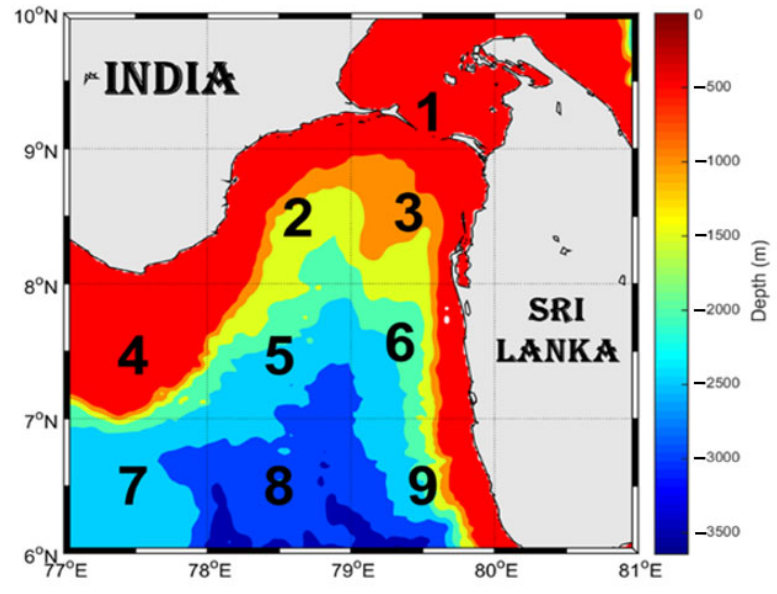
Figure 1. Bathymetry of the study area.